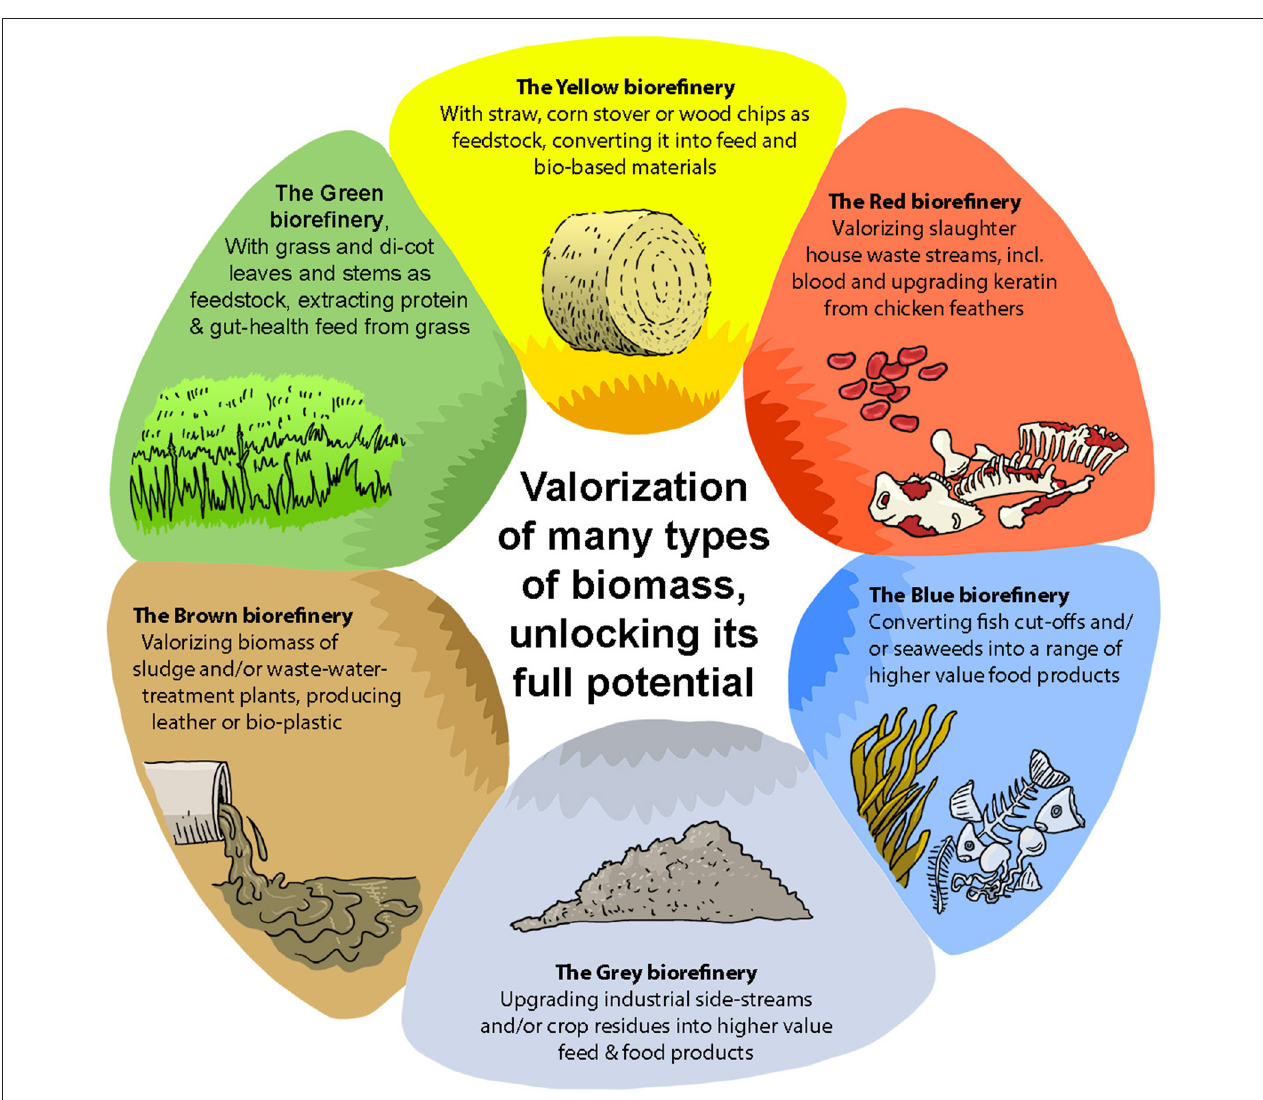
FIGURE 1 | A color code of the basic six types of biomass conversion is here illustrated. Notably, the color code is not just an easy overview; it groups together different types of biorefinery processing, reflecting the recalcitrance of the biomass, yellow very recalcitrant, plant cell wall rich; green, lignocellulosic but more accessible, needing less pretreatment; blue and red include primarily animal, wall-less biomass (viz. no lignocellulosic recalcitrance). The gray (or white) is often food compatible as it is residue from a food processing, and brown is mixed and wet, with special precautions with regard to